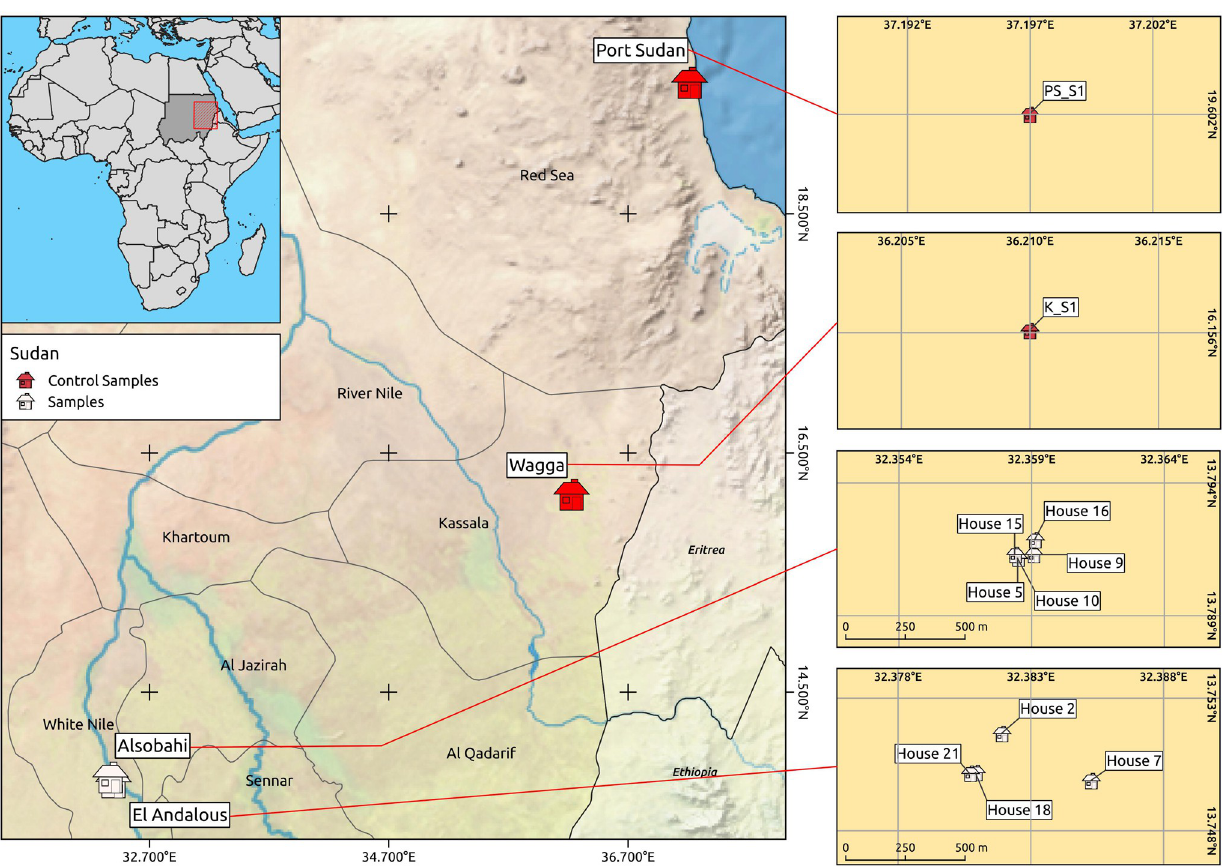
Fig 1. Left: sites of sampling from Sudanese eumycetoma endemic (White Nile) and not endemic (Kassala and Port Sudan) regions. Right: images of the sampled houses. The map was generated with QGIS 3.10.4-Coru ñ a on Ubuntu 20.04.4 LTS. Background and administrative limits: http://www. naturalearthdata.com/about/terms-of-use/): https://www.naturalearthdata.com/downloads/10m-cultural-vectors/10m-admin-0-countries/ https://www. naturalearthdata.com/downloads/10m-cultural-vectors/10m-admin-1-states-provinces/ https://www.naturalearthdata.com/downloads/10m-natural-earth- 2/10m-natural-earth-2-with-shaded-relief-water-and-drainages/.